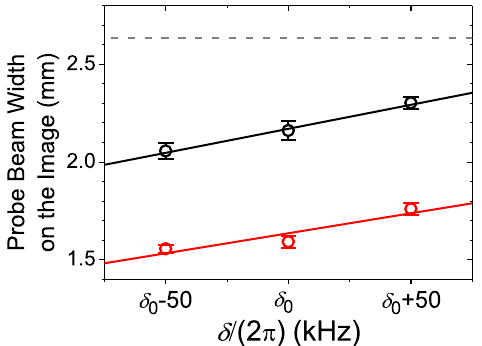
Fig. 6 The output probe beam width as a function of the two-photon detuning. Black and red circles are the experimental data of the e − 1 full width of the output probe beam versus the two-photon detuning. The black (or red) data points were taken at α (optical depth) = 82, Ω c = 1.0 Γ , Δ c = 1.0 Γ , and Ω p = 0.10 Γ (or 0.20 Γ ). Black and red lines are the linear best fi ts of the experimental data, and their slopes are 2.5 μ m/kHz and 2.1 μ m/kHz, respectively. The Gray dashed line indicates the probe beamwidth measured without the presence of the atoms, i.e., the input probe beamwidth. The error bars represent the standard deviation of measured